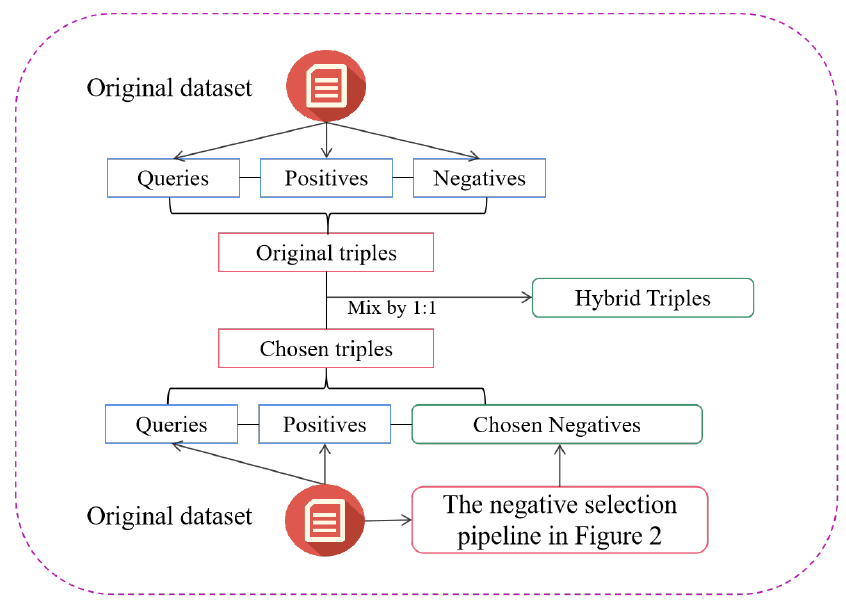
Figure 2. The pipeline of negative choices from the original dataset. (1) A BART model is fine-tuned with query-positive pairs; (2) the fine-tuned BART model generates queries from the negatives; (3) the similarity scores of queries and generated queries are calculated after being encoded by a BERT model; (4) choose negatives of which the similarity scores are higher than the threshold.